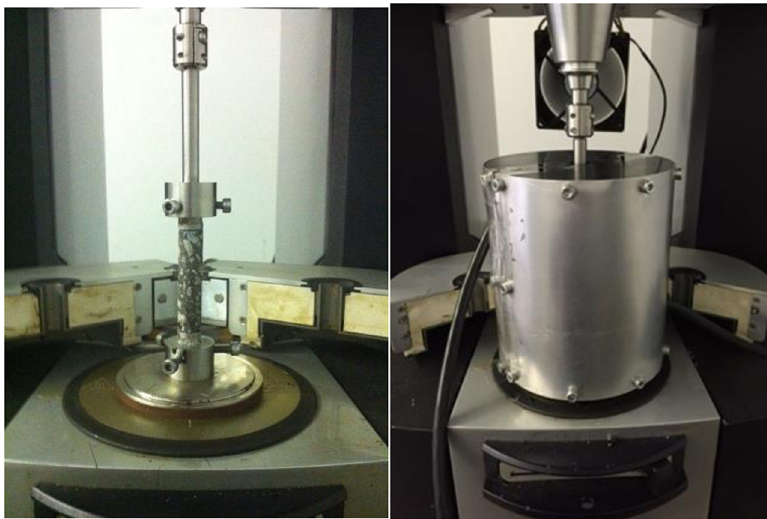
Figure 3: DSR sample ready for testing in the